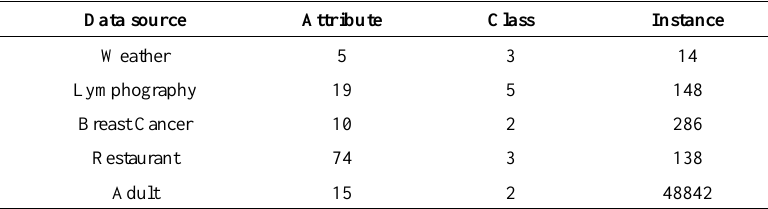
Table 1. Characteristics of candidate data sources used in experiments [6]